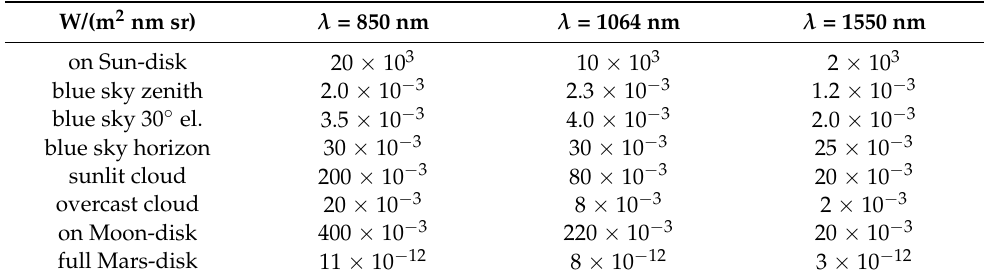
Table 1. BGL spectral irradiance at different wavelengths. W/(m 2 nm sr)